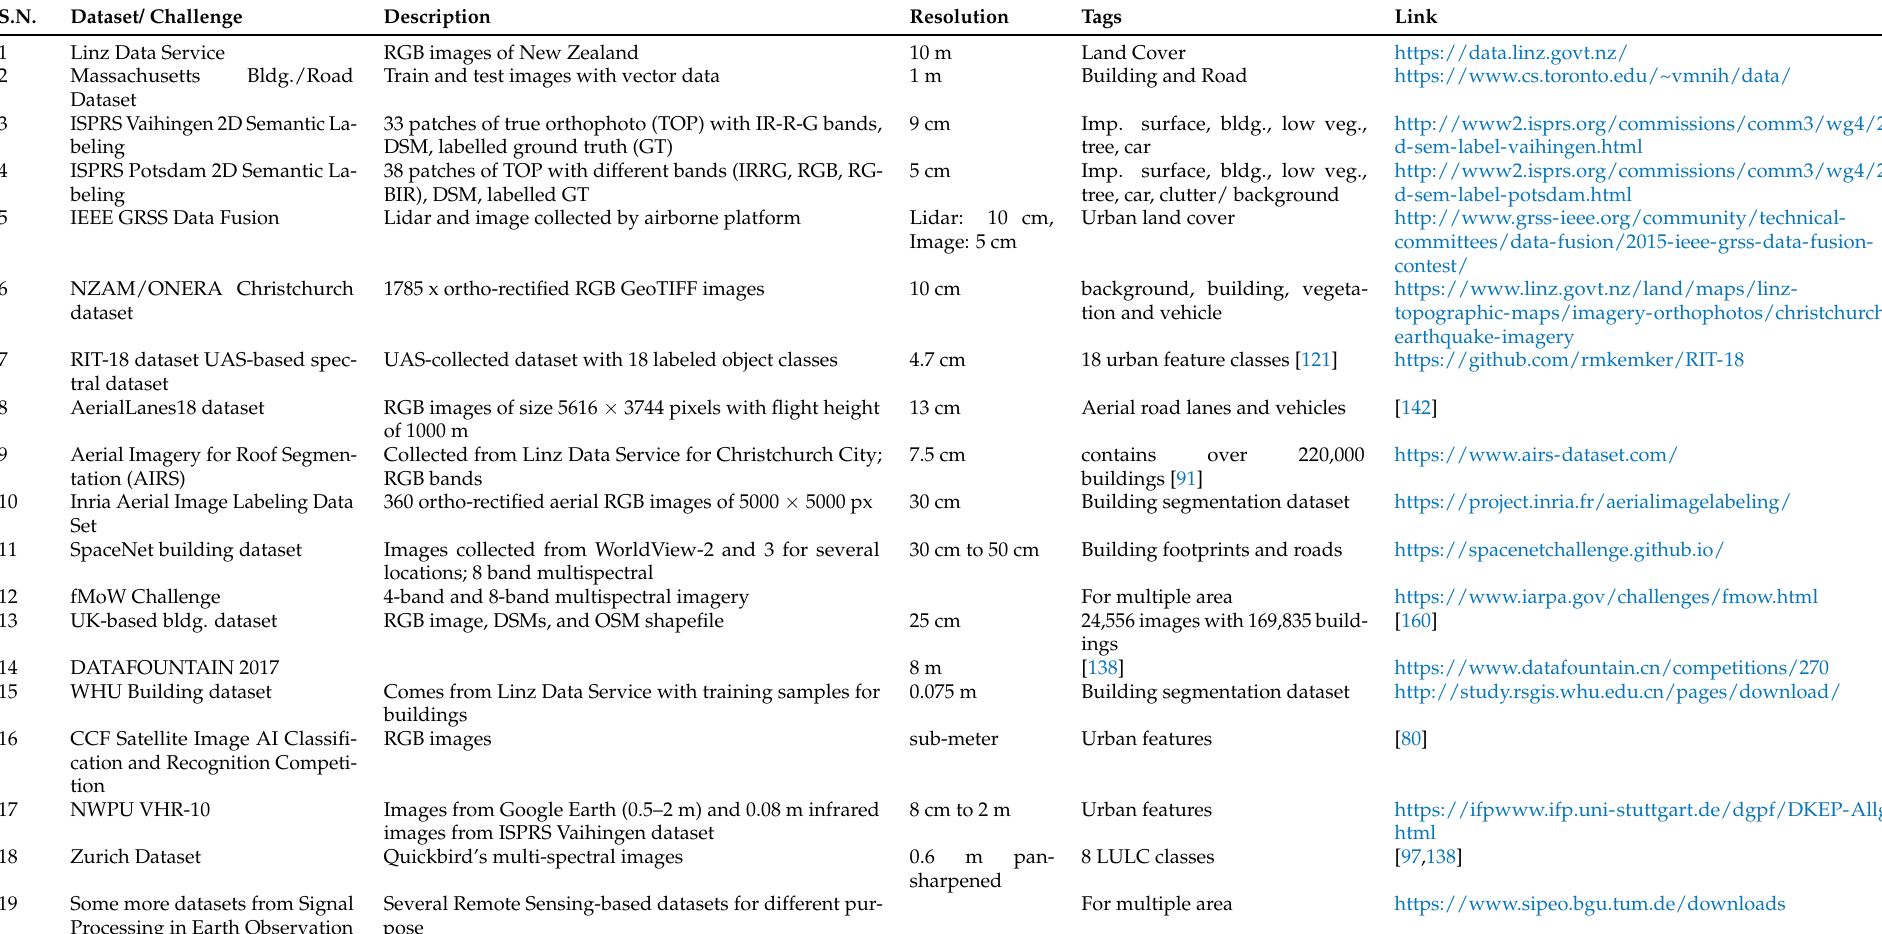
Table A3. Datasets for Urban LULC